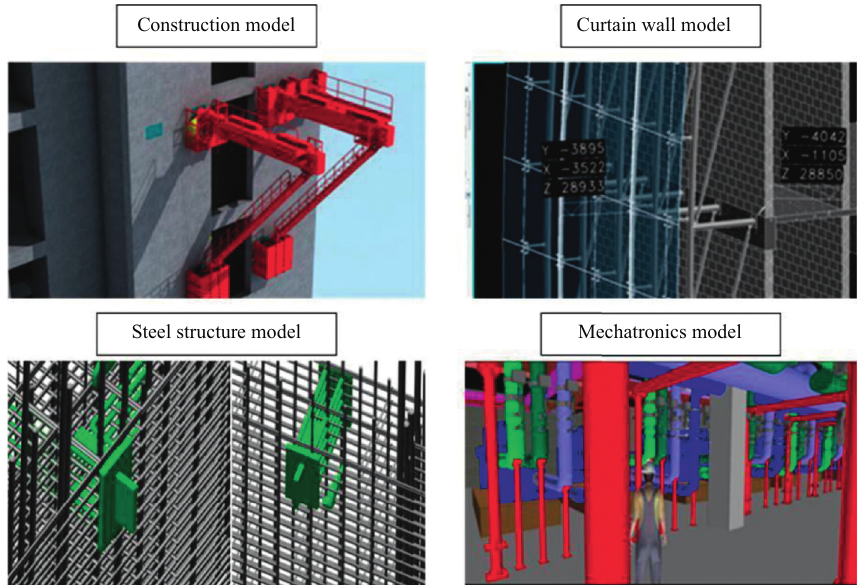
Figure 13: The refinement of some 3D submodels.